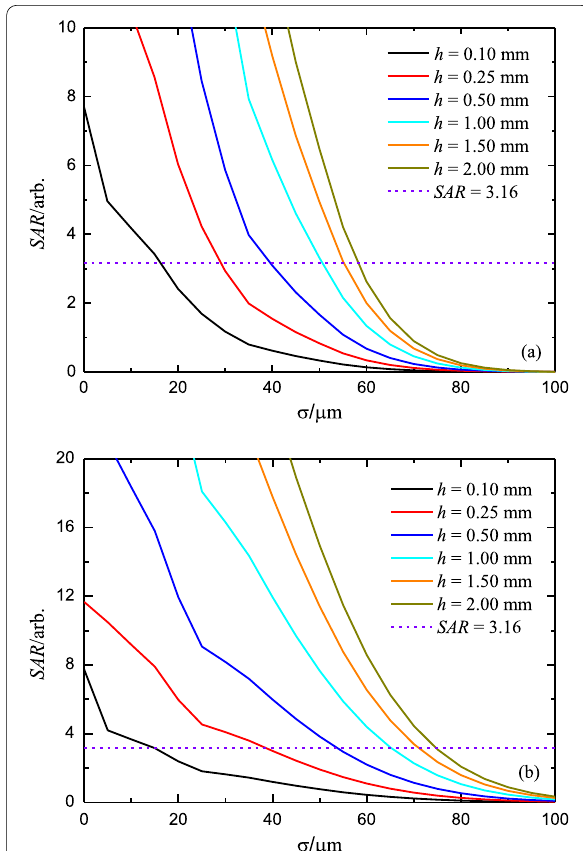
Figure 9 SAR values of cracks with different depths under a rough front surfaces and b rough back surfaces